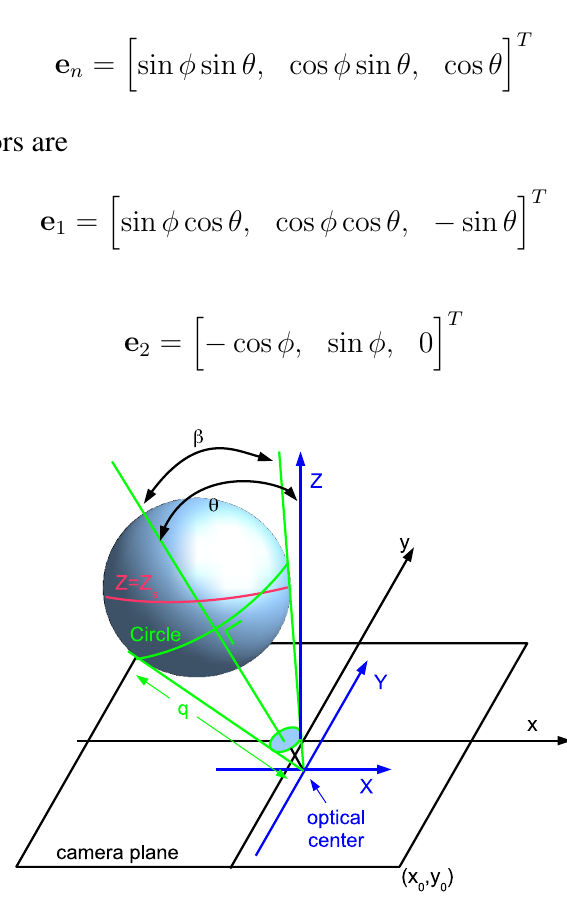
Figure 1. Projection of a